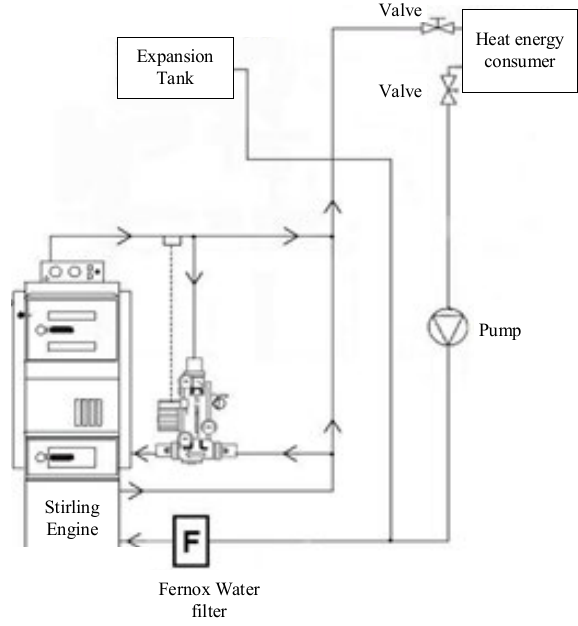
Fig. 5 . Drawing of the connection of experimental mCHP equipment with the Heat energy consumer